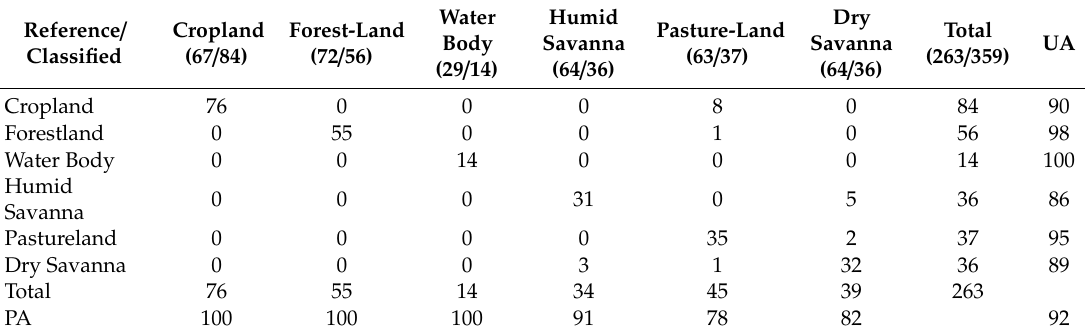
Table 3. Confusion matrix among the major land use and land cover classes from Mato Grosso state using the validation dataset. The values in parentheses indicate the number of training and validation samples, respectively. UA, user accuracy; PA, producer accuracy. Overall accuracy = sum of diagonal / total number of samples = 243 / 263 =